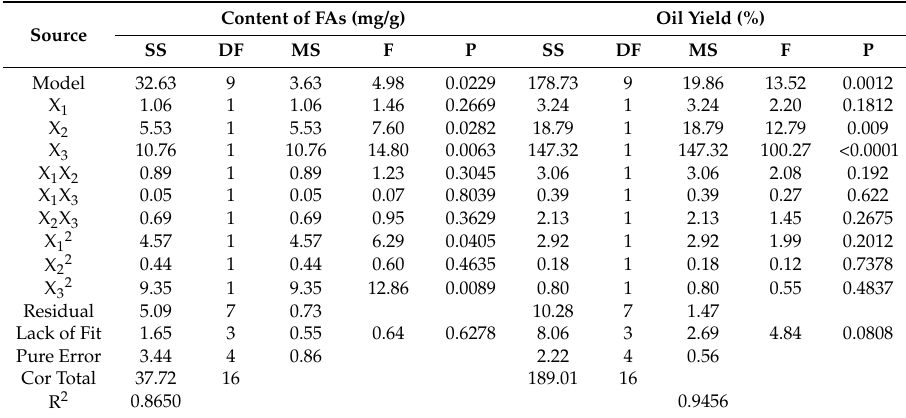
Table 4. ANOVA for the regression